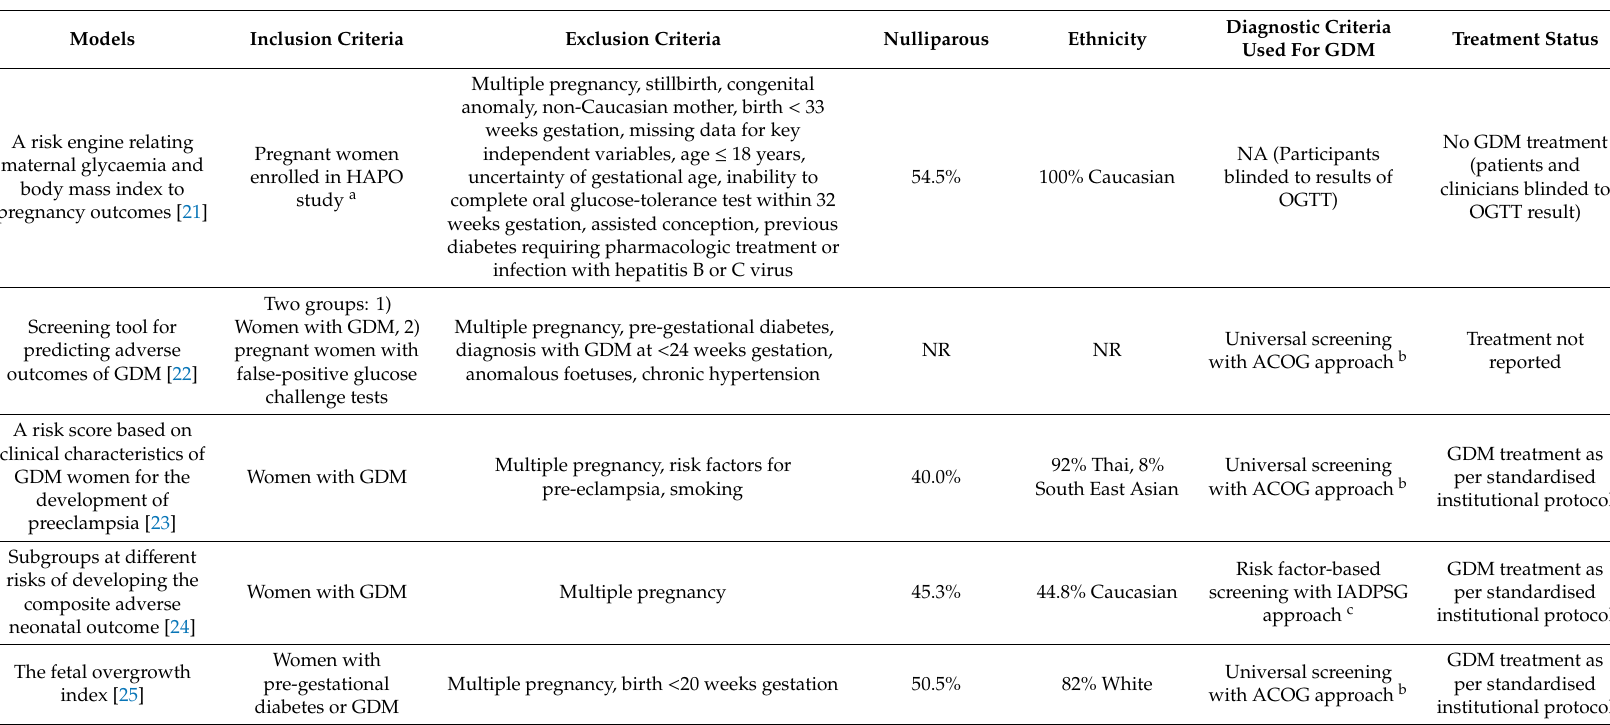
Table 3. Clinical characteristics of the study populations used to develop models for pregnancy complications in women with gestational diabetes.